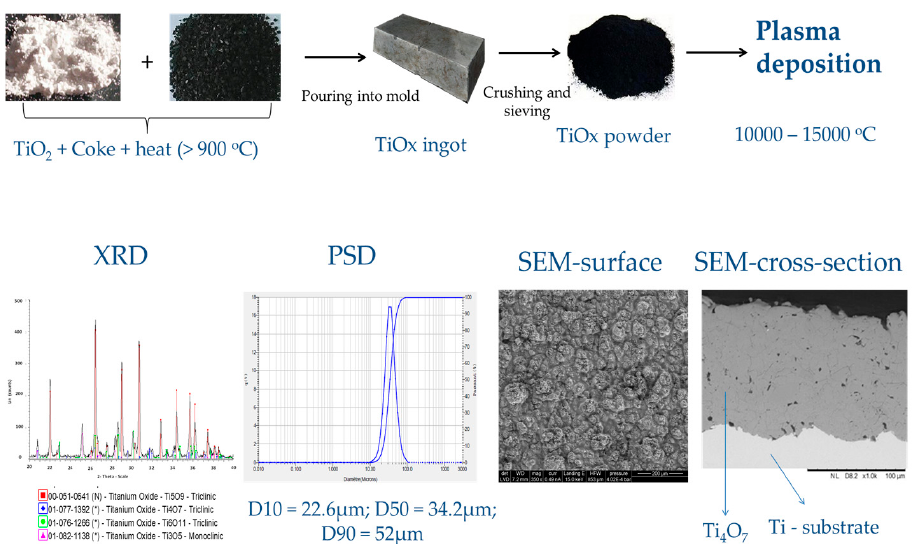
Figure 6. A typical synthesis route for the preparation of plasma elaborated Ti 4 O 7 and some of its structural properties. Adapted from [18].